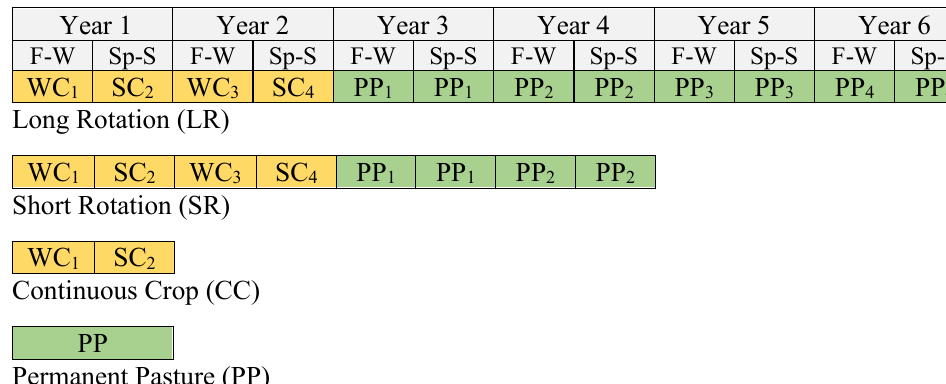
Figure 3. Original design of the pasture–crop rotations under no-till technology in the ‘Palo a Pique’ long-term experiment (1995). F: fall; W: winter; Sp: spring; S: summer; WC: winter crop ( Lolium multiflorum L., Avena strigosa L.); SC: summer crop ( Sorghum bicolor L., Setaria italica L.); PP: permanent improved pasture re-seeded every 5 years. Numeric subscripts (1,2,3,4) means the sequential order of the crops or pasture age. Orange and green boxes represent the crop and pasture phase, respectively. Each rectangle covering one year corresponds to a 6 ha paddock.